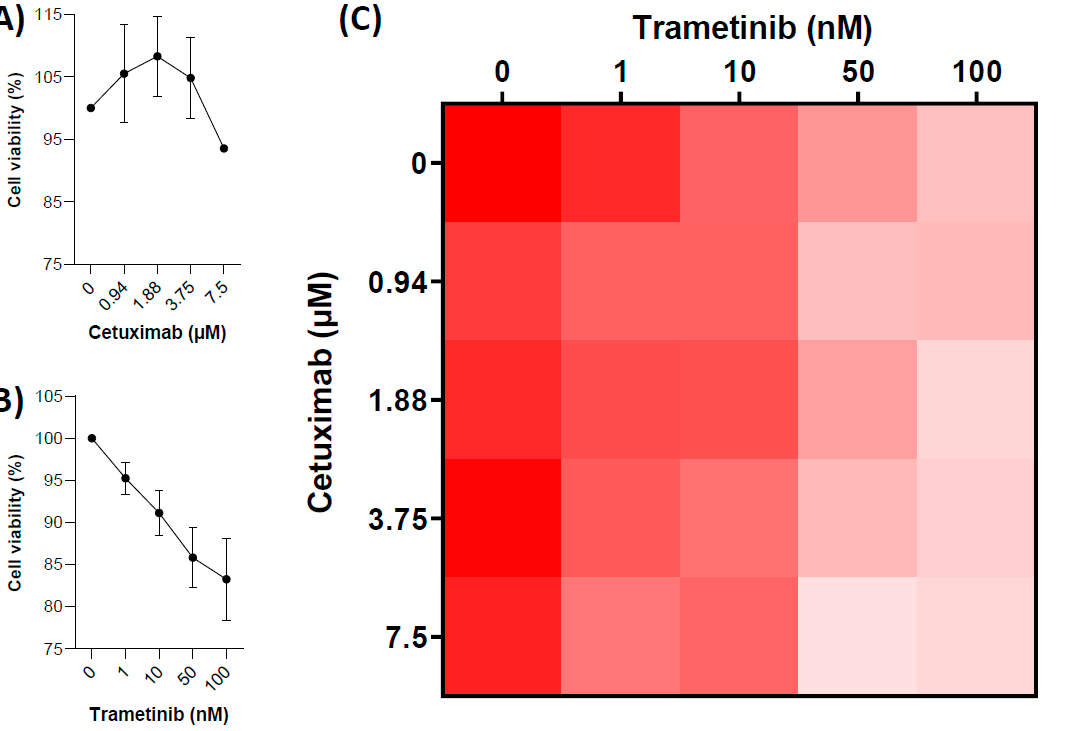
Figure 2. Effects of Trametinib or/and Cetuximab on human OVCAR-5 ovarian cancer cell line. Human OVCAR-5 ovarian cancer cell line was treated with indicated concentrations of Trametinib or/and Cetuximab for 48 h. ( A , B ) Cell viability was analyzed using crystal violet staining. ( A , B ) Relative absorbance compared to untreated according to the dose of Trametinib ( A ) or Cetuximab ( B ). ( C ) Relative viability of treatment combination. Experiments were performed three times with three replicates each time.